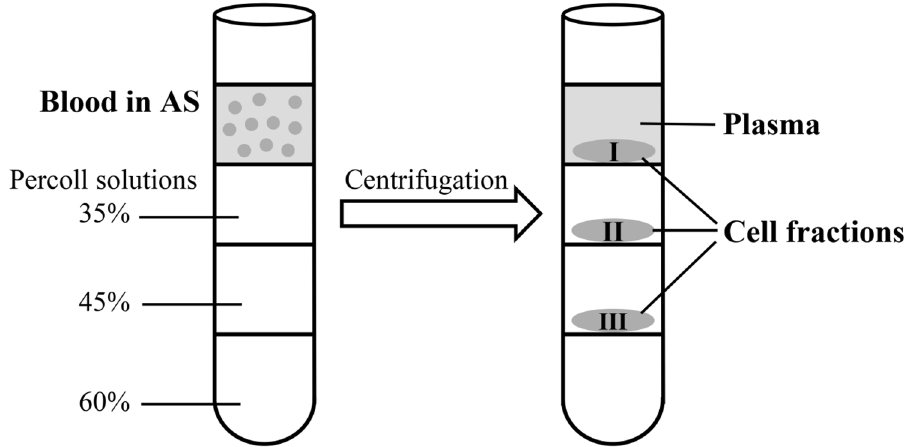
Figure 9. Scheme of blood cells fractionation in Percoll density gradient. AS anticoagulation